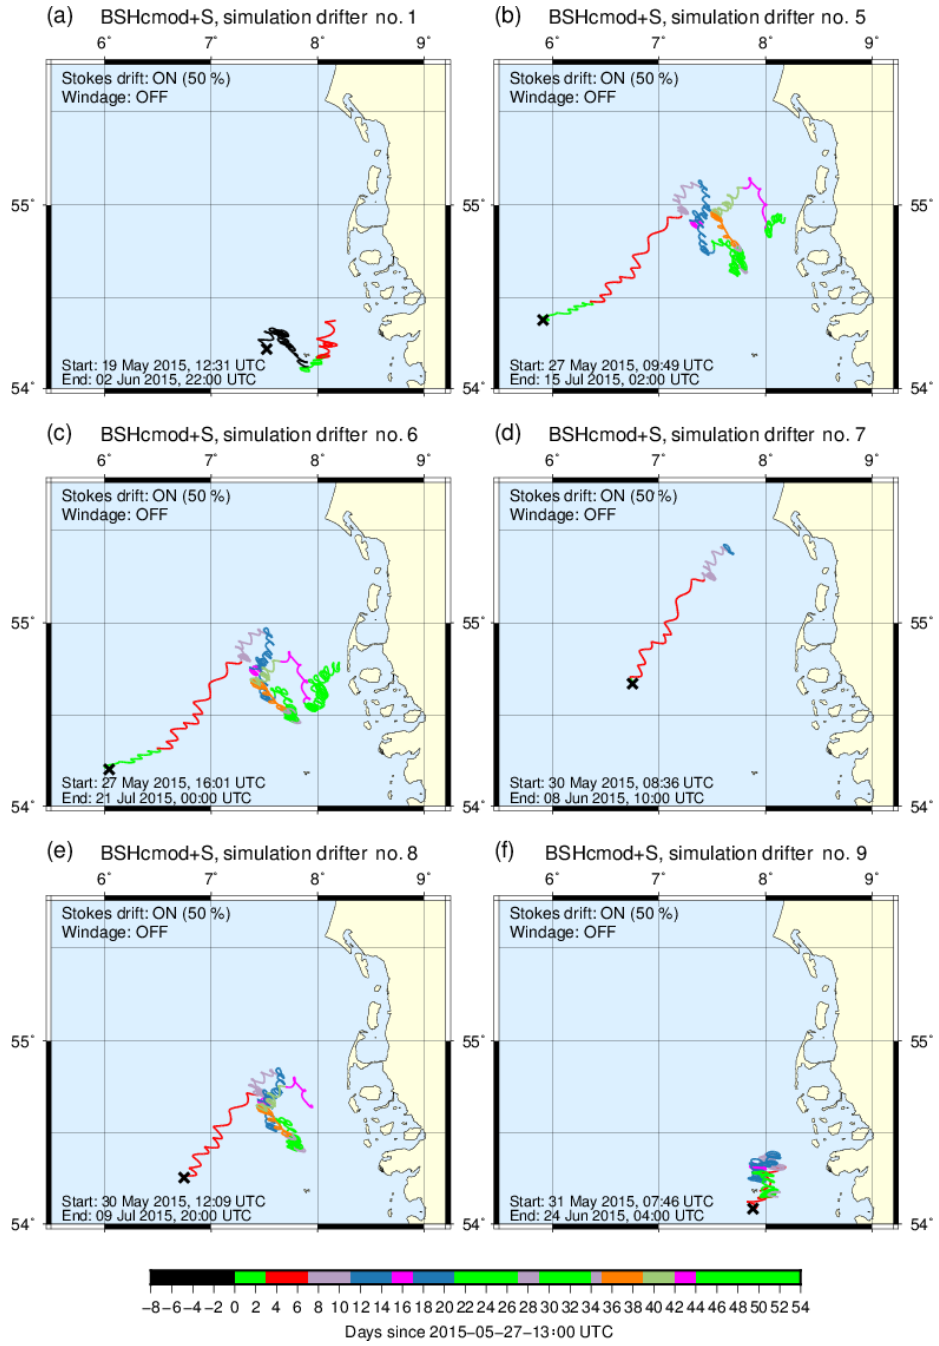
Figure A3. Simulations based on BSHcmod top-layer currents plus 50% of surface Stokes drift from WAM (BSHcmod + S). Black crosses indicate locations where simulations were